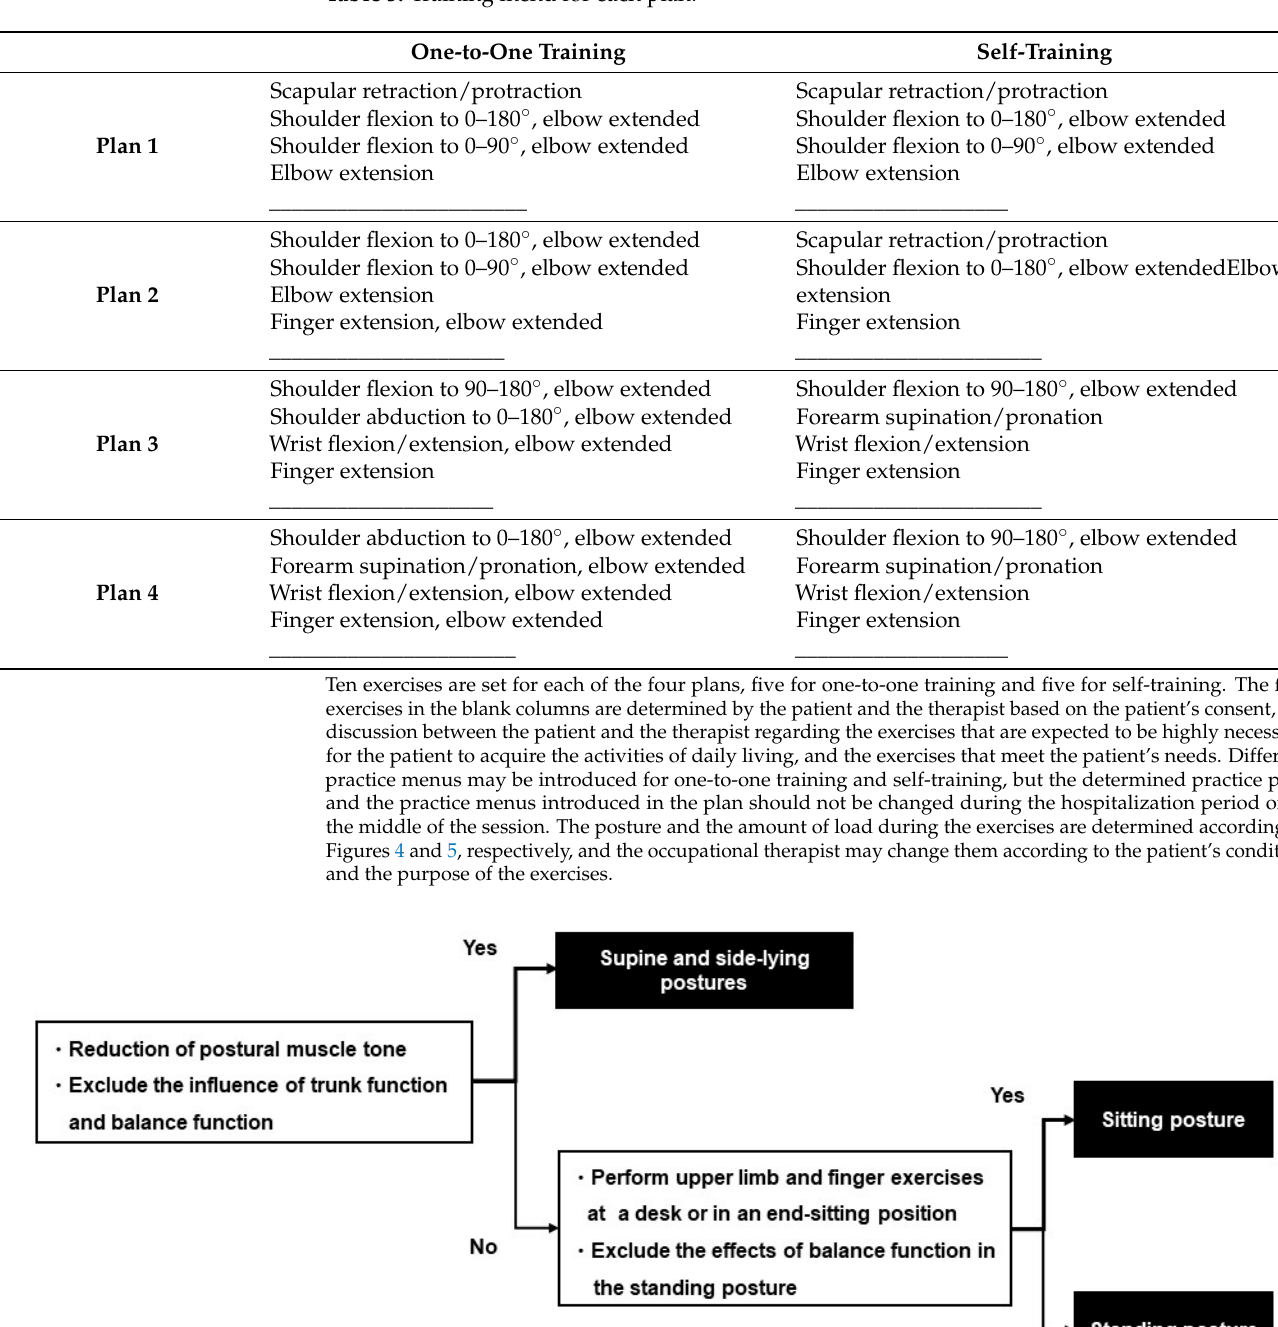
Table 3. Training menu for each